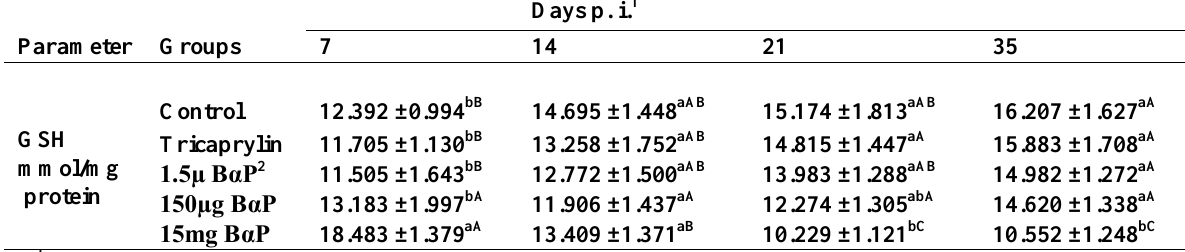
Table (1): Changes in glutathione (GSH) concentration (mmol/mg protein) in liver tissue homogenate (mean ± SD) of broiler males treated with